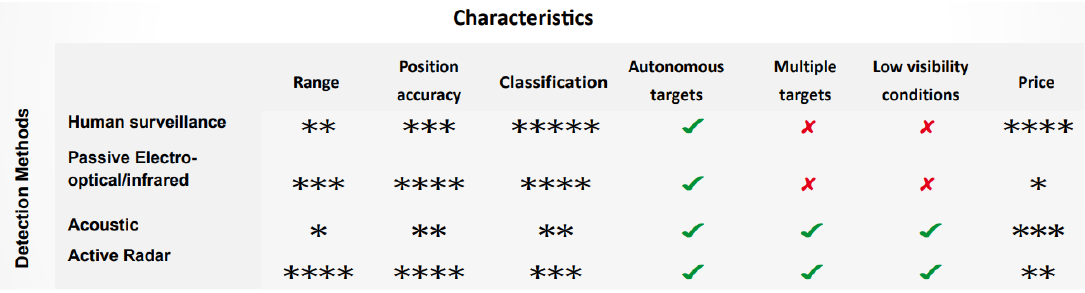
Figure 1. Comparison of key characteristics between individual components of counter-UAV